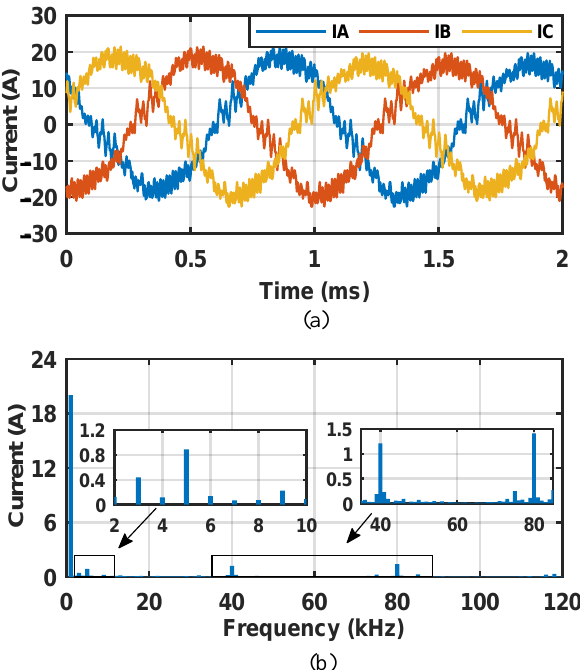
Figure 18. The current of the SVPWM algorithm with the OVDT of the 2-norm. ( a ) The three-phase current. ( b ) The harmonic of the